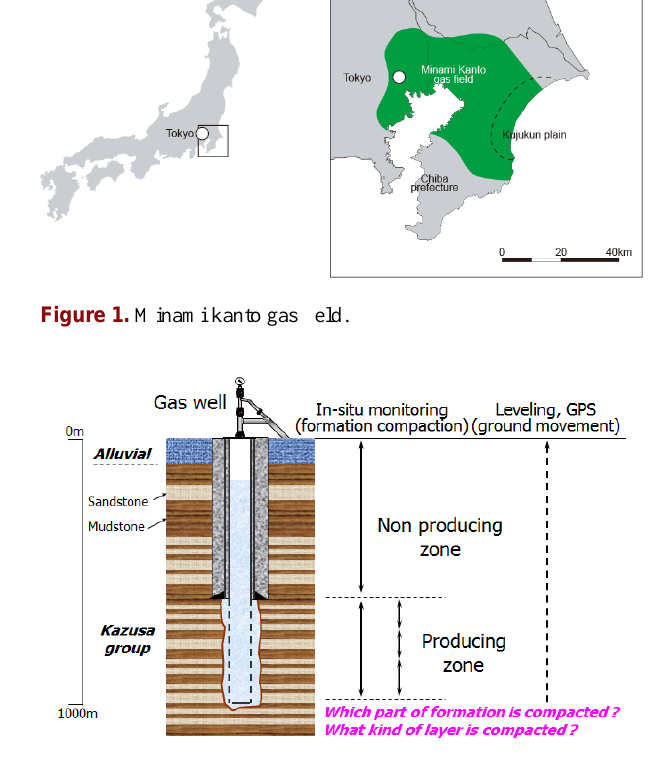
Figure 2. Concept of in situ formation compaction monitoring.